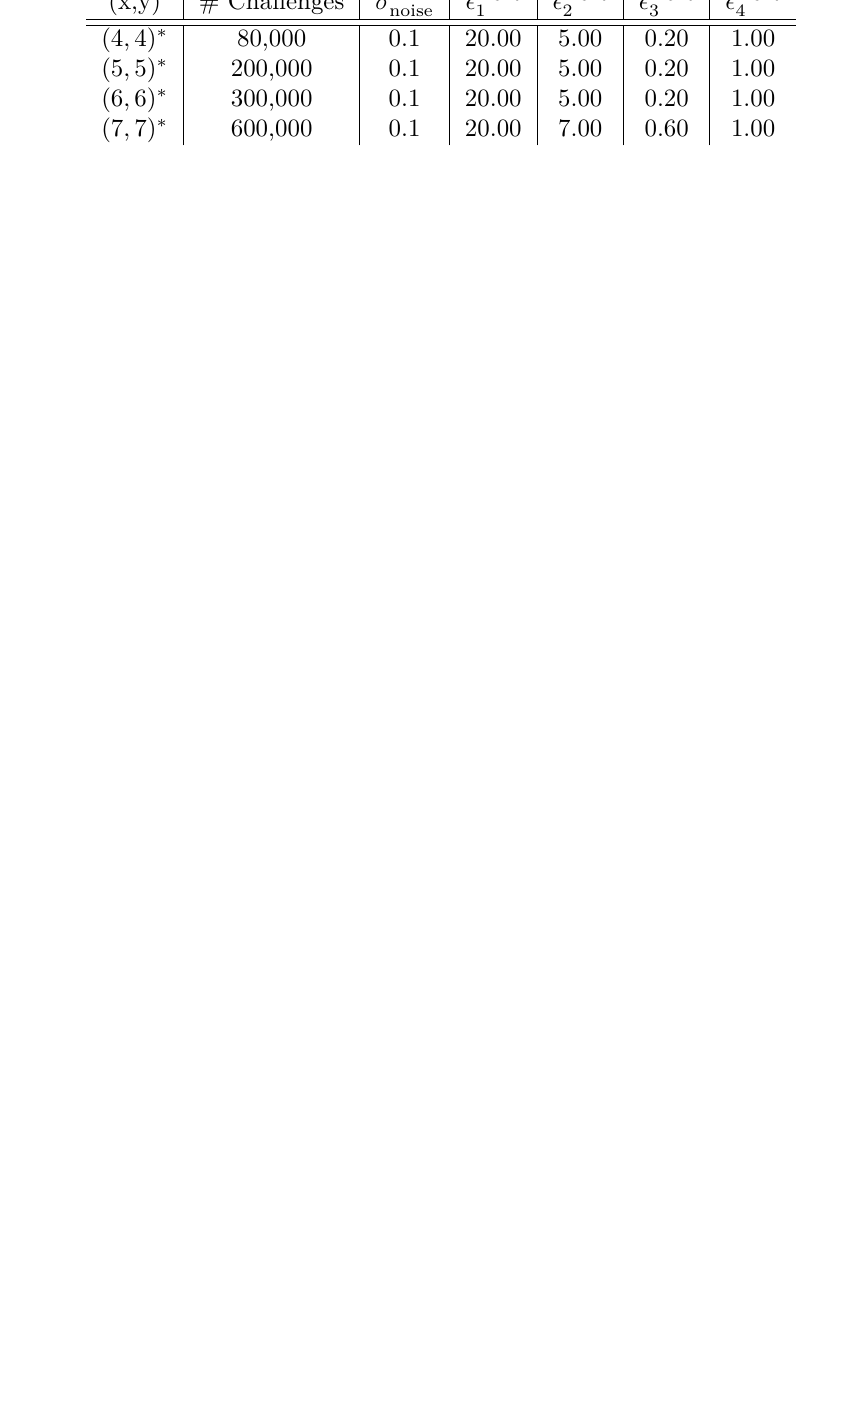
Table 8: Constraints for the second step of multi-pass experiments in Table 3. (x,y) # Challenges σ 2 (4 , 4) ∗